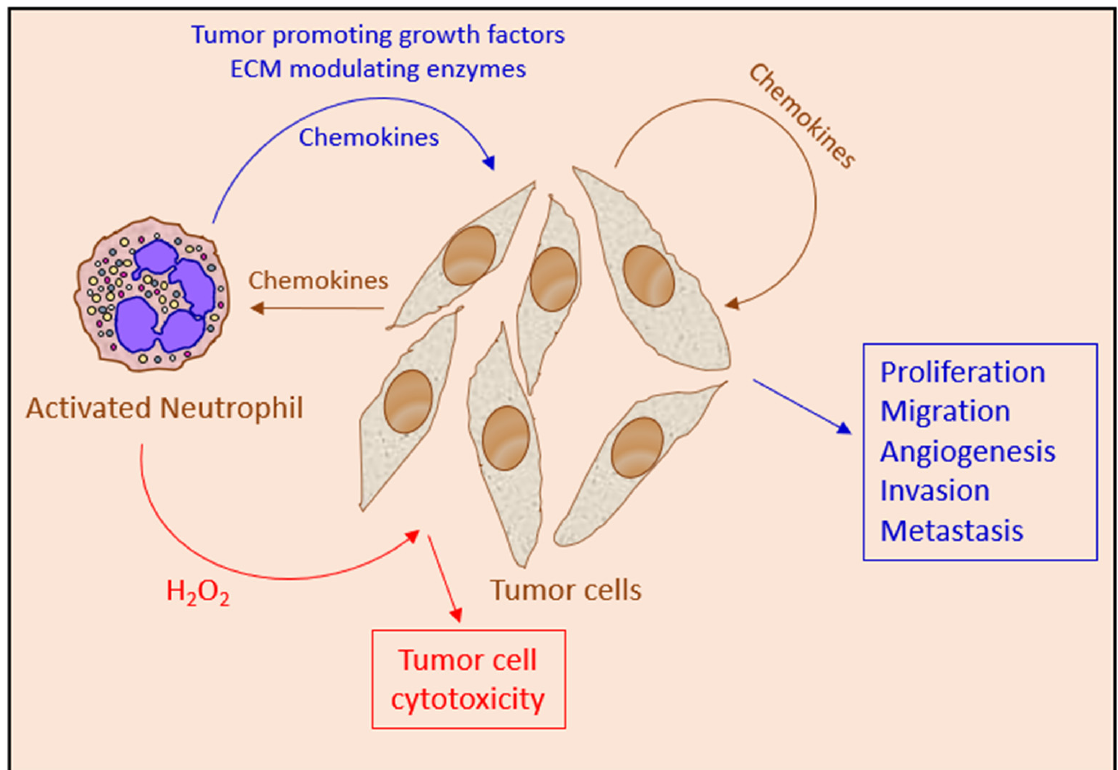
Figure 2. The opposite effects of chemokines in neutrophil tumor biology. Chemokines produced by tumor cells and neutrophils might induce proliferation and migration of the tumor cells. The chemokines also activate neutrophils to produce both tumor cytotoxic factors, such as H 2 O 2 , and pro-tumor factors, such as additional chemokines, growth factors, and ECM modulating enzymes. Thus, the tumor-attracted neutrophil can both exert anti-tumor and pro-tumor actions. Another example of neutrophil–tumor cell crosstalk is the finding that GM-CSF secreted by human breast cancer cells increases CD11b/CD18 (Mac-1) expression on neutrophils, which interacts with ICAM-1 expressed on the tumor cells, resulting in subsequent neutrophil-mediated transendothelial migration of the tumor cells